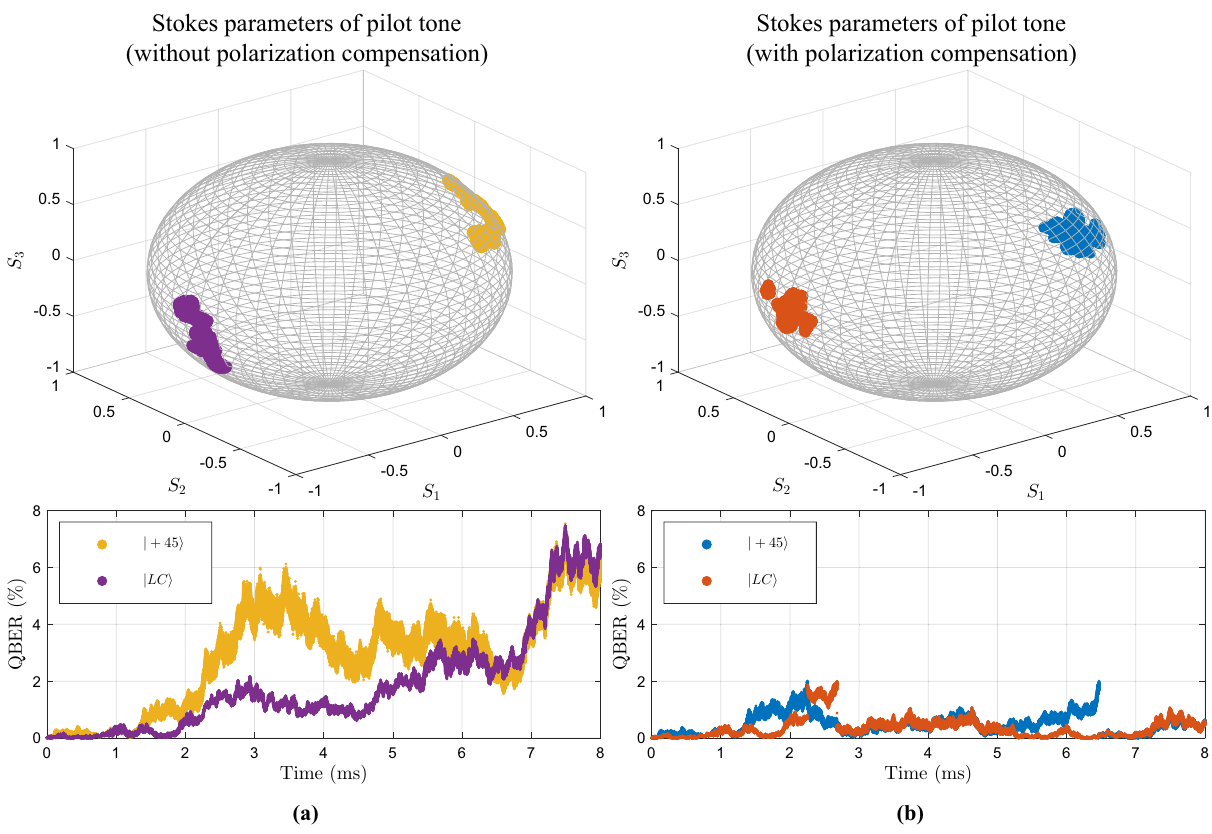
45 RL and sent in the pilot tone, and | � | �